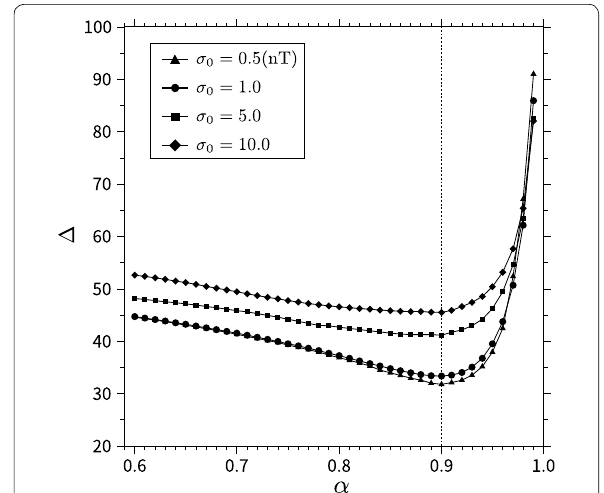
Fig. 10 Plot of (cid:31) for α . Plot of (cid:31) for α in the range of 0.60–0.99 with an interval of 0.01, using the weighting function w S 2 . The solid triangles, circles, squares, and diamonds indicate the case of σ 0 1.0, 5.0, and 10.0 nT, respectively